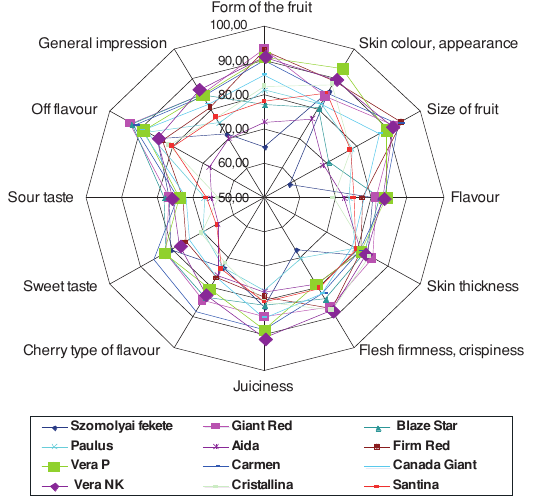
Figure 6. Profile diagram of the evaluation of mid season ripening sweet cherry varieties according to sensorial judgement